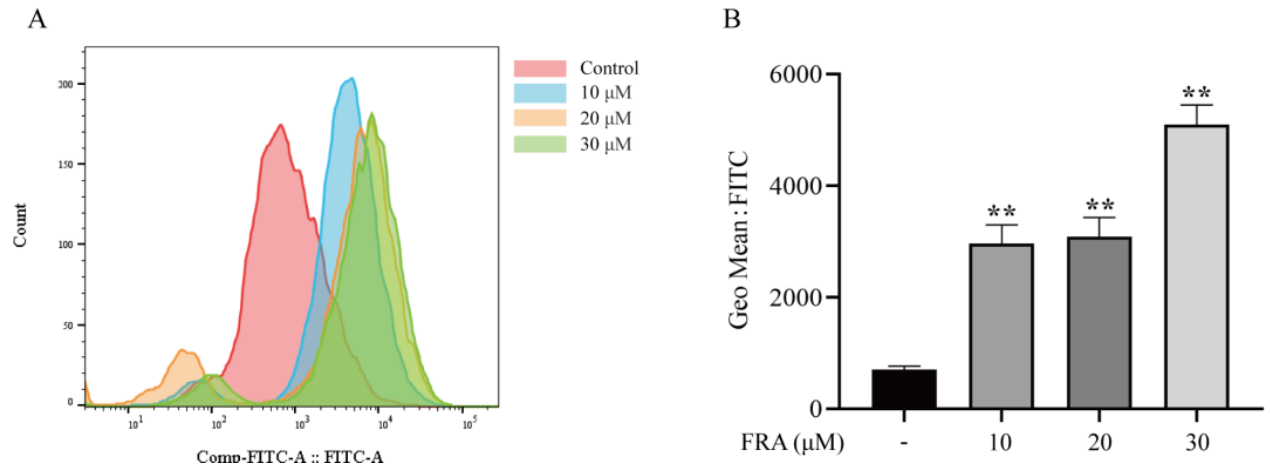
Figure 4. At 48 h after FRA treatment, flow cytometry was performed to determine ROS levels ( A ) and average fluorescence intensity ( B ). Data are presented as the mean ± SD. Each experiment was performed 3 times with 50 randomly selected zebrafish larvae. ** p < 0.01 vs. control.